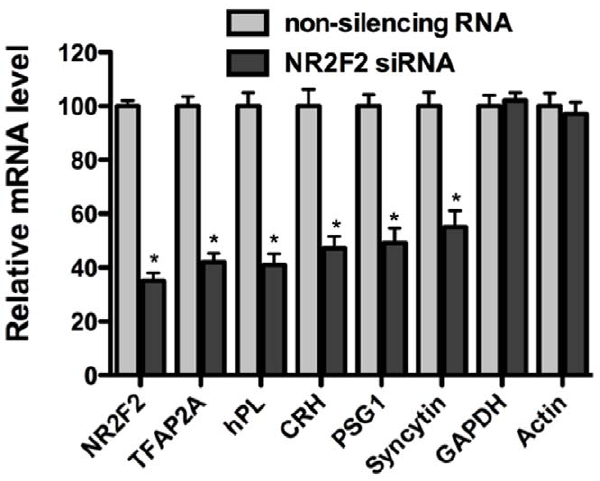
Figure 3. The effects of NR2F2 gene silencing on TFAP2A mRNA levels and the mRNA levels of the syncytiotrophoblast cell markers, hPL, CRH, PSG1 and syncytin. Human cytotropho- blast cells were transfected in two separate experiments with a NR2F2